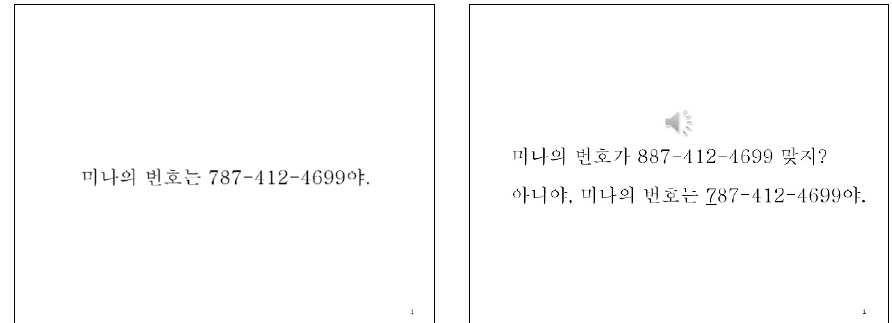
Figure 3. Screenshots of the production experiment. The left panel corresponds to a broad-focus condition in which the target sentence means ‘Mina’s number is 787-412-4699 ′ in English. The right panel corresponds to a corrective-focus condition in which the upper sentence means ‘Mina’s number is 887-412-4699. Right?’, and the lower sentence means ‘No, Mina’s number is 787-412-4699.’.